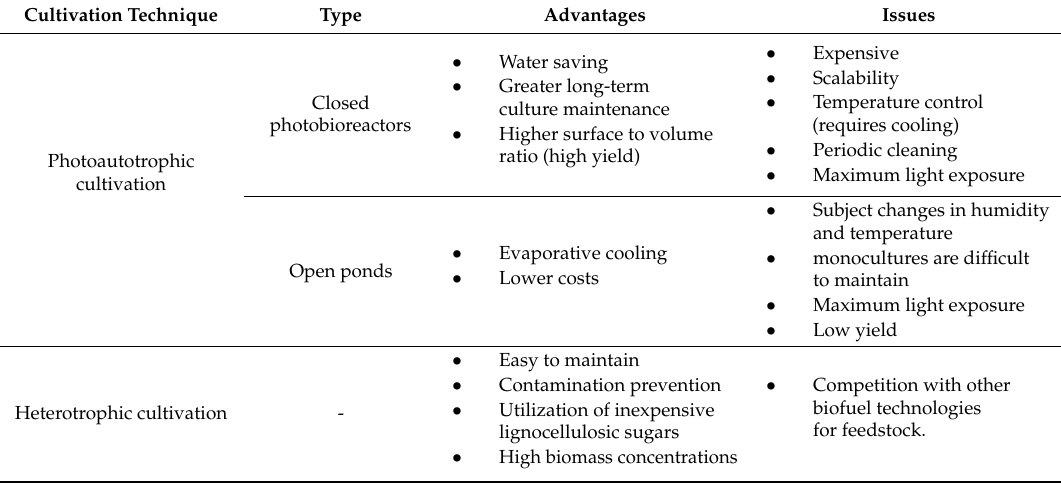
Table 1. Comparison of features and challenges of algal cultivation